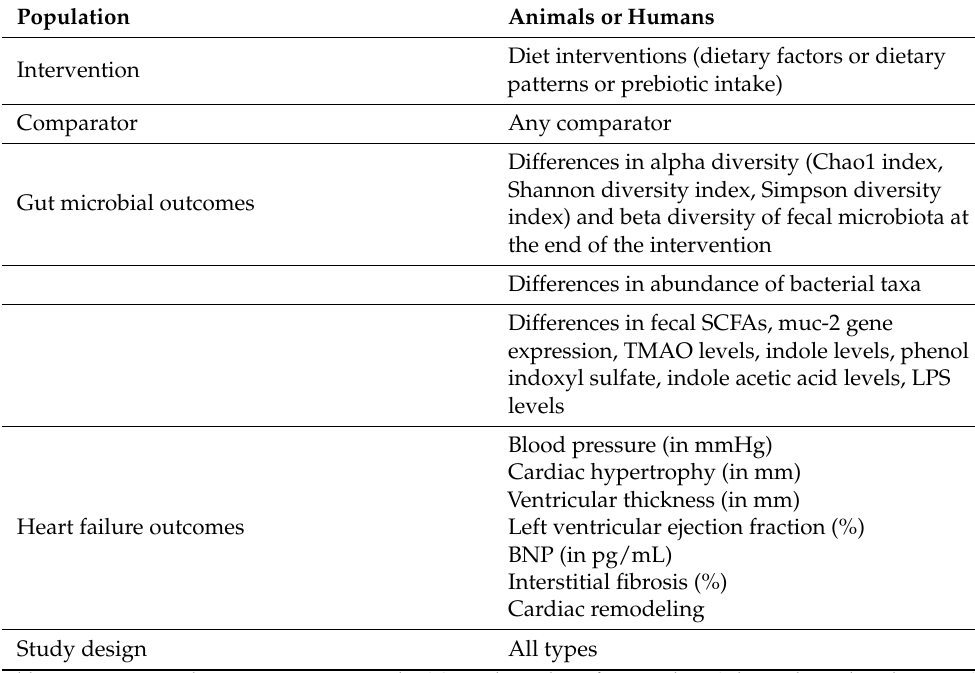
Table 1. PICOS criteria for inclusion of